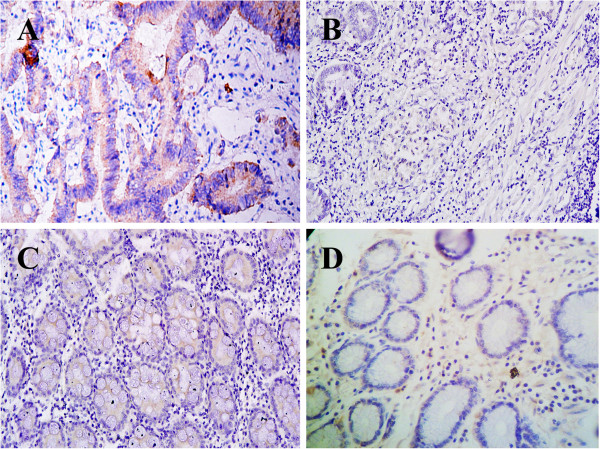
C-Met protein expression determined by IHC staining in gastric carcinoma and adjacent normal tissues (SP × 100). A: c-Met protein expression in gastric cancer. B: Negative expression in gastric cancer. C: Positive staining for c-Met in adjacent normal mucosa. D: Negative staining for c-Met protein.